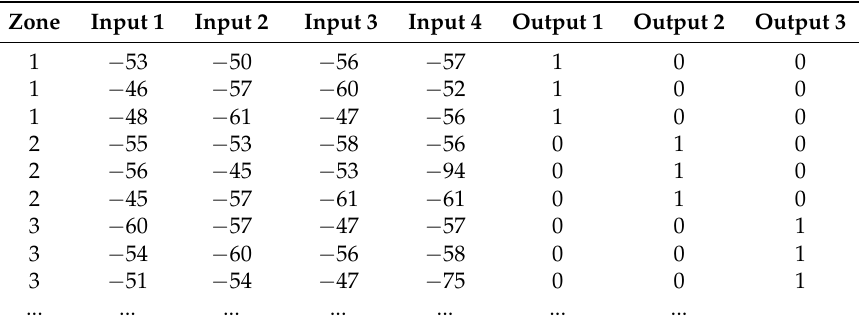
Table 5. Sample of collected data for Scenario 2.